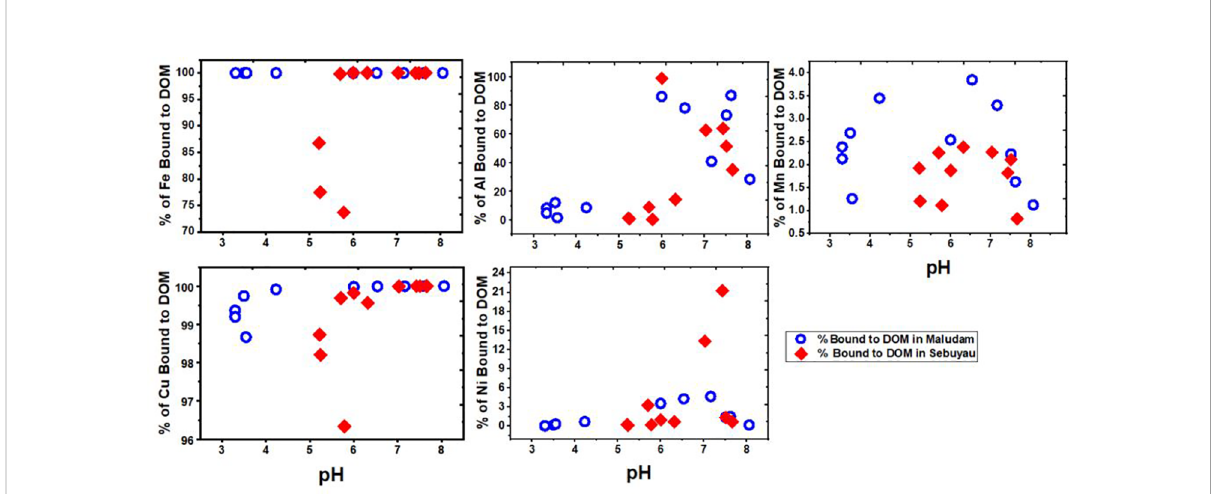
FIGURE 8 Model results of trace element af fi nity to DOM as a function of pH in Maludam and Sebuyau rivers and estuaries for dissolved Fe, Al, Mn, Cu and Ni. The output shows the percentage of trace elements bound to DOM according to the NICA-Donnan